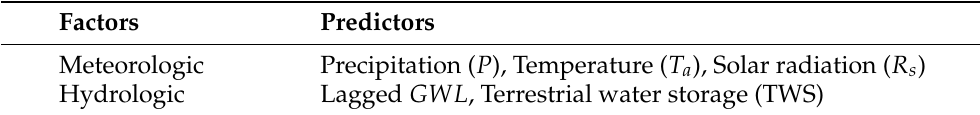
Table 3. Factors and predictors used in IAI-based groundwater level